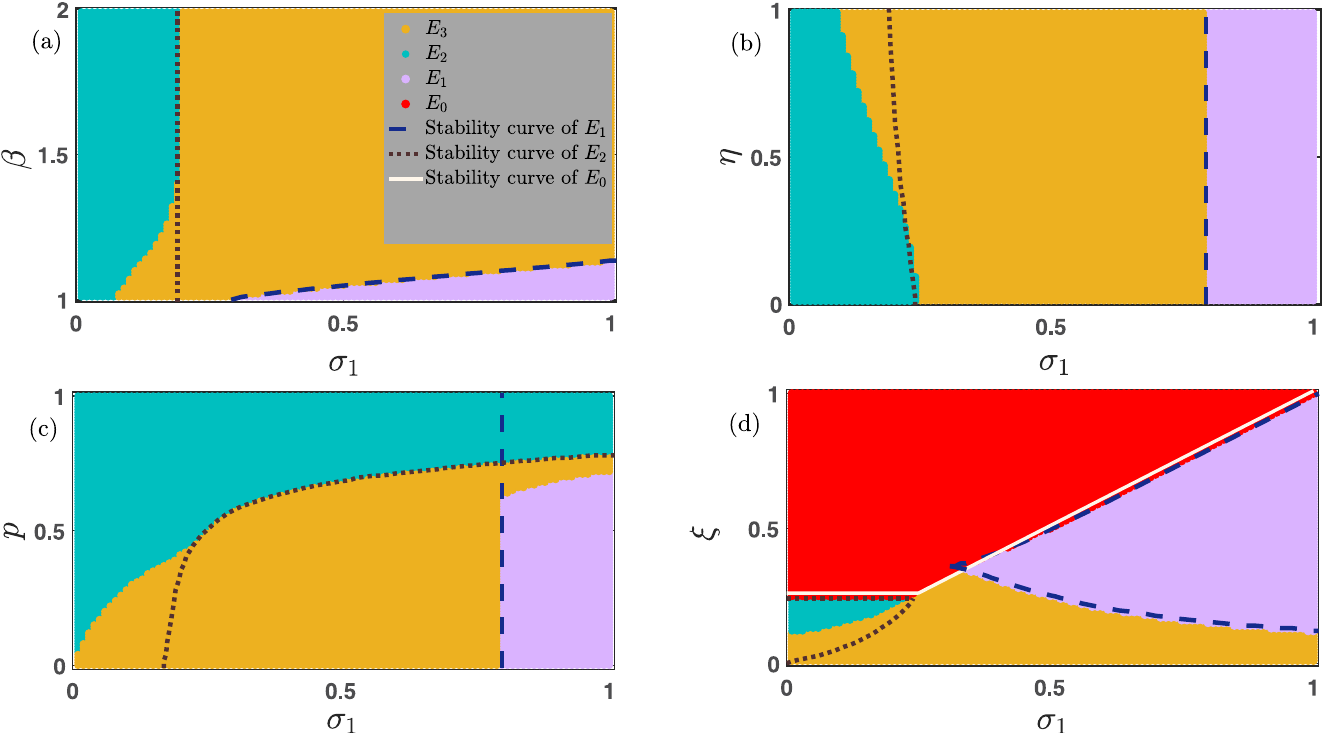
Fig 4. Importance of σ 1 in the enhancement of cooperation. Four different parameter spaces (a) σ 1 − β , (b) σ 1 − η , (c) σ 1 − p , and (d) σ 1 − ξ are contemplated here with fixed initial condition x 0 = 0.35 and y 0 = 0.35. σ 1 is varied within [0, 1], and the other parameters’ values are for the subfigures (a) ξ = 0.15, η = 0.85, p = 0.30, σ 2 = 0.25, and μ = 0. β is varied within the open interval (1, 2), (b) ξ = 0.15, β = 1.1, p = 0.30, σ 2 = 0.25 and μ = 0. η is varied within (0, 1), (c) ξ = 0.15, β = 1.1, η = 0.85, σ 2 = 0.25, and μ = 0. p is varied within the closed interval [0, 1], and (d) β = 1.1, η = 0.85, p = 0.30, σ 2 = 0.25 and μ = 0. ξ is varied within the interval (0,1]. The color code represents the following: (i) red represents the extinct state, (ii) yellow portrays the co-existence state, (iii) violet displays the defector-free state, and (iv) sea blue depicts cooperator-free state, respectively. We have run the numerical simulations for 20 × 10 5 iterations for each point and store the final value for determining the final asymptotic state. Increment of σ 1 contributes more to the cooperators’ payoff, and hence, we observe a defector-free region for higher values of σ 1 depending on the other parameters. We draw the stability curves for E 0 (the solid white line), E 1 (the blue dashed line), E 2 (the brown dotted line), and E 3 (the solid blue line).